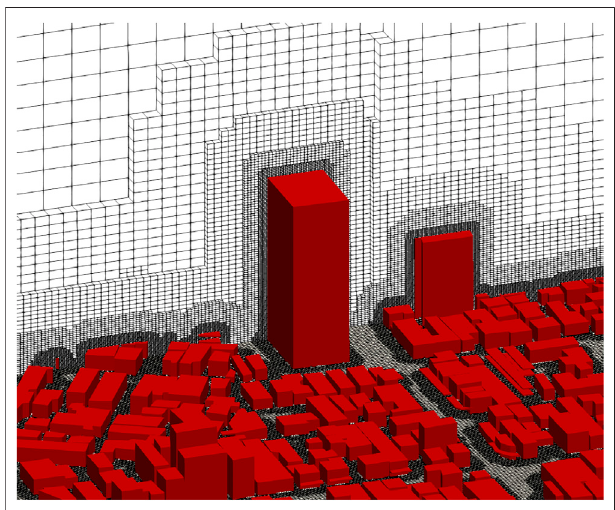
FIGURE 2 | Computational grid structure, a partial view from the